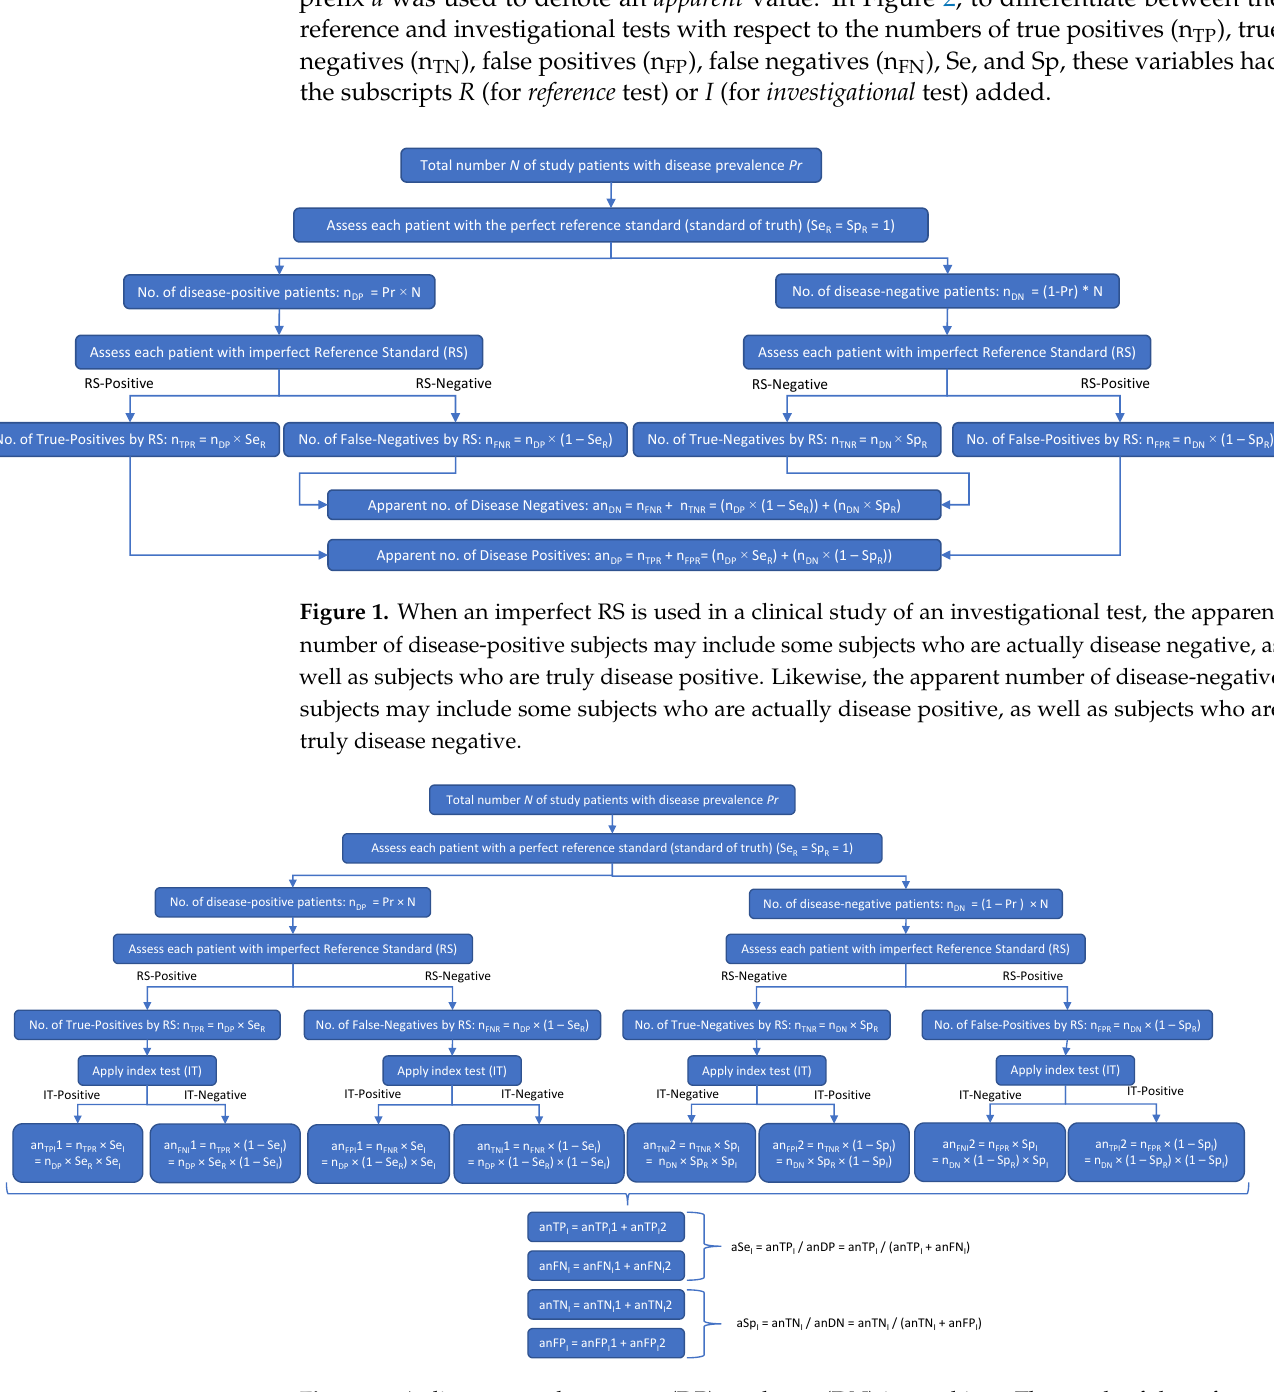
Figure 2. A disease may be present (DP) or absent (DN) in a subject. The result of the reference standard (RS) test may be accurate (true positive [TPR] or true negative [TNR]) or inaccurate (false positive [FPR] or false negative [FNR]). The result of the investigational test (IT) may then agree with the RS (yielding an apparent number of true positives [an TP ] and an apparent number of true negatives [an TN ]) or disagree with the RS (yielding an apparent number of false positives [an FP ] and an apparent number of false negatives [an FN ]). The an TP will equal the number of subjects who got a true-positive result on both the RS and the IT, plus the number of subjects who got a false-positive result on both the RS and the IT. Likewise, an TN will equal the number of subjects with a true-nega- tive result on both the RS and the IT, plus the number of subjects with a false-negative result on both the RS and the IT. Thus, both the apparent sensitivity and the apparent specificity of the IT (i.e., the sensitivity and specificity calculated in the clinical study) will depend on both the sensitivity and specificity of the RS (Se R and Se R ).